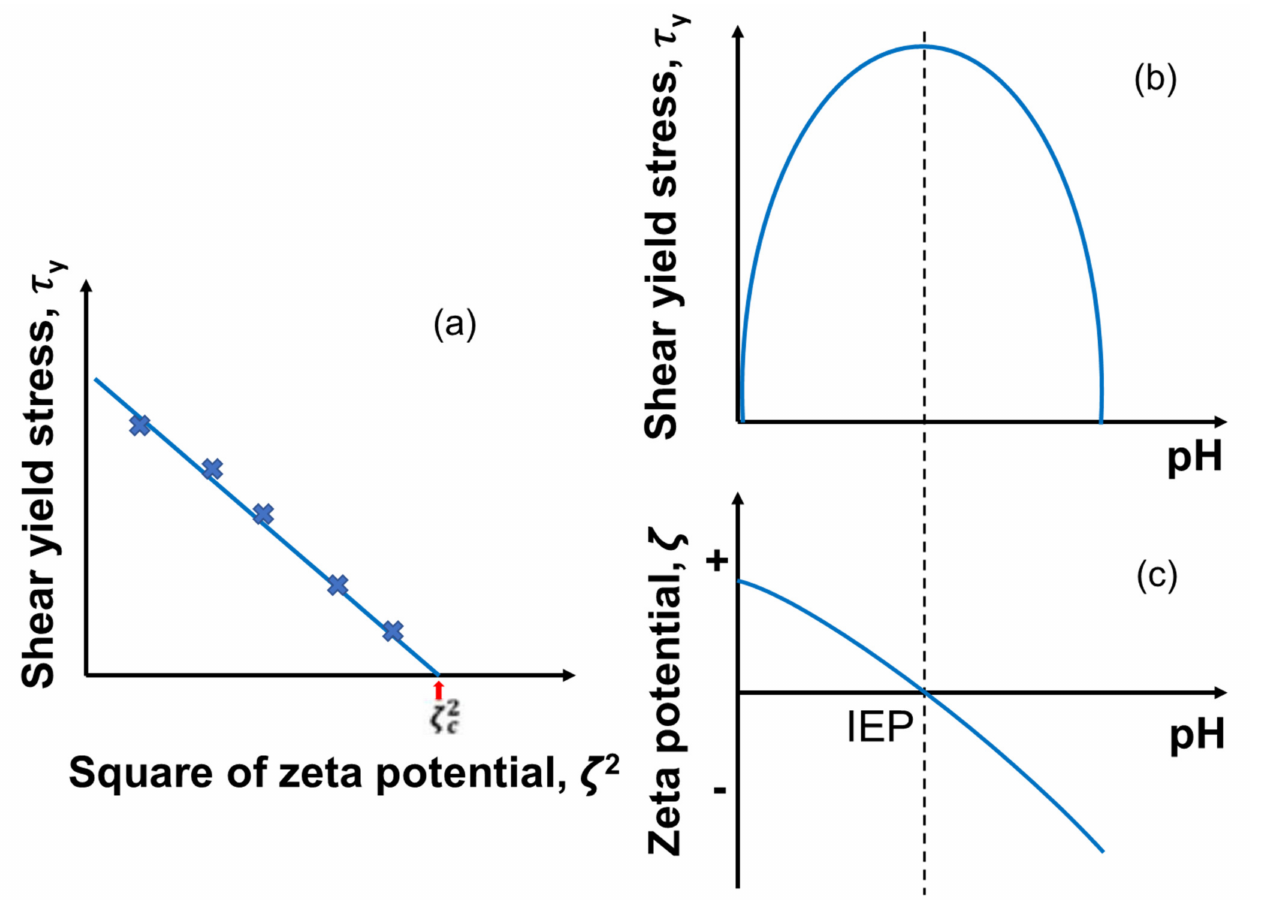
Figure 7. Typical correlation between the shear yield stress and the electrostatic interaction character- ized by zeta potential for a homogeneous charged inorganic particle suspension. ( a ) The shear yield stress as a function of the square zeta potential, ( b ) the shear yield stress as a function of pH, and ( c ) zeta potential as a function of pH. Redrawn and modified with permission from [213]. Copyright 2021 Wiley Analytical